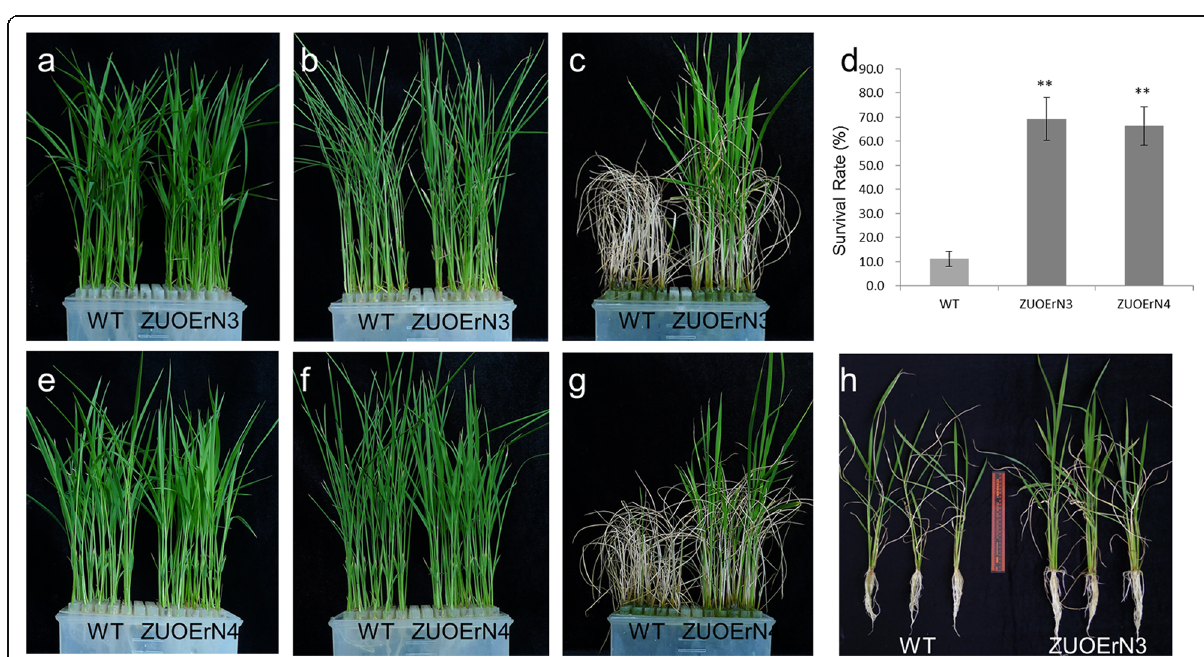
Fig. 3 Drought tolerance of WT and OsNAC2 overexpression plants. Seeds were germinated in water and transferred to Kimura B nutrient solution. Two-week-old seedlings were treated in Kimura B nutrient solution containing 10% PEG 6000. Plants before treatment ( a , e ), 10% PEG- treated for 3 d ( b , f ), and after 8 d treatment and then recovery for 8 d ( c , g ), are shown. d : The survival rate of WT and transgenic lines treated with 10% PEG 6000 in c and g. Error bars show the SD of three biological replicates ( n = 60). ** P < 0.01 ( t- test). h : The phenotype of WT and OsNA C2 overexpression line ZUOErN3 plants treated with 15% PEG 6000 for 5 d and allowed to recover for 7 d. Three independent experiments were performed. ZUONrE3, ZUOErN4: OsNAC2 overexpression plants